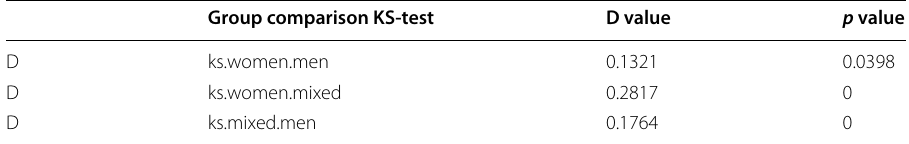
Table 6 Pairwise group comparisons (Kolmogorow–Smirnow-test) for skewness degree of gendered communities Group comparison KS-test D value p value D ks.women.men 0.1321 0.0398 D ks.women.mixed 0.2817 0 D ks.mixed.men 0.1764